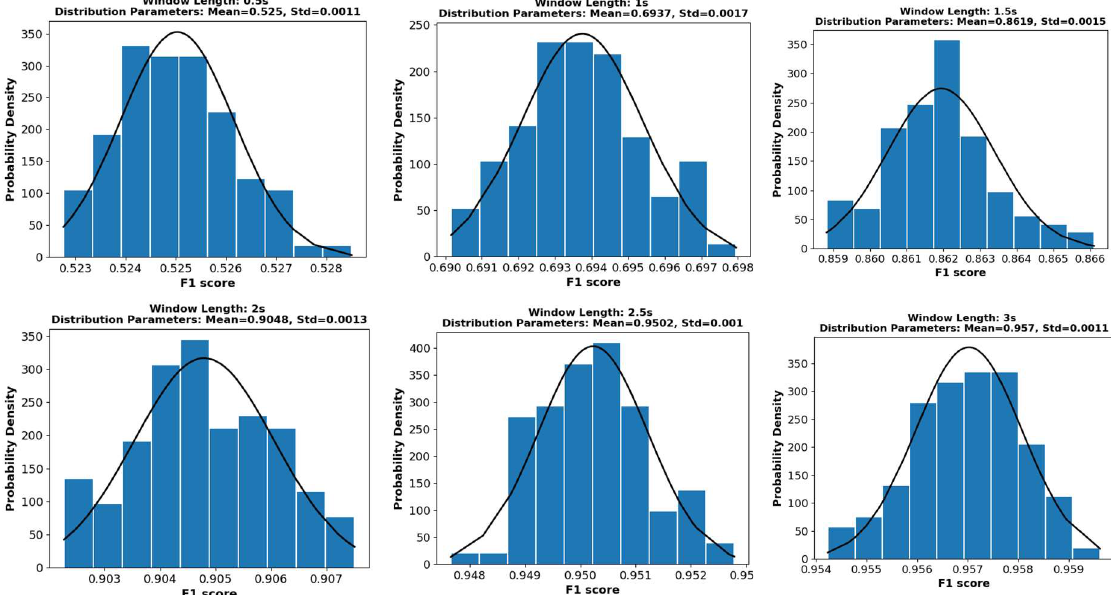
Figure 4. The 100-time bootstrapping results of motion mode recognition using support vector machine (SVM) and different window lengths (0.5–3 s).